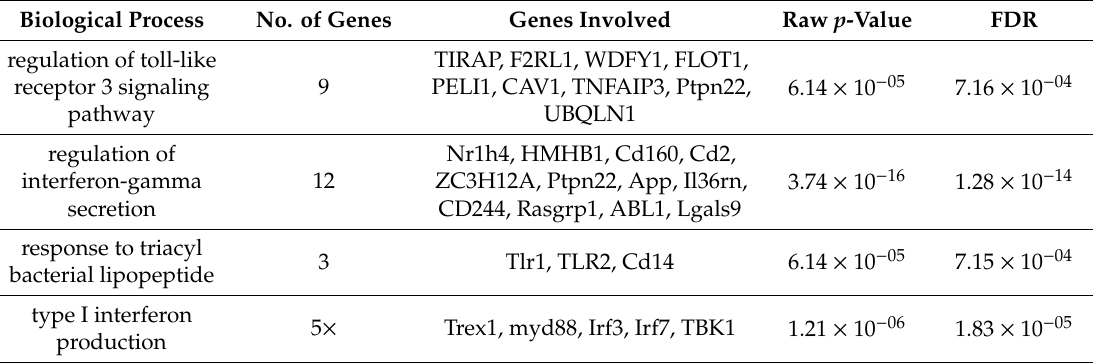
Table 3. GO analysis of 2388 annotations; the immune-related terms have been chosen based on FDR p <